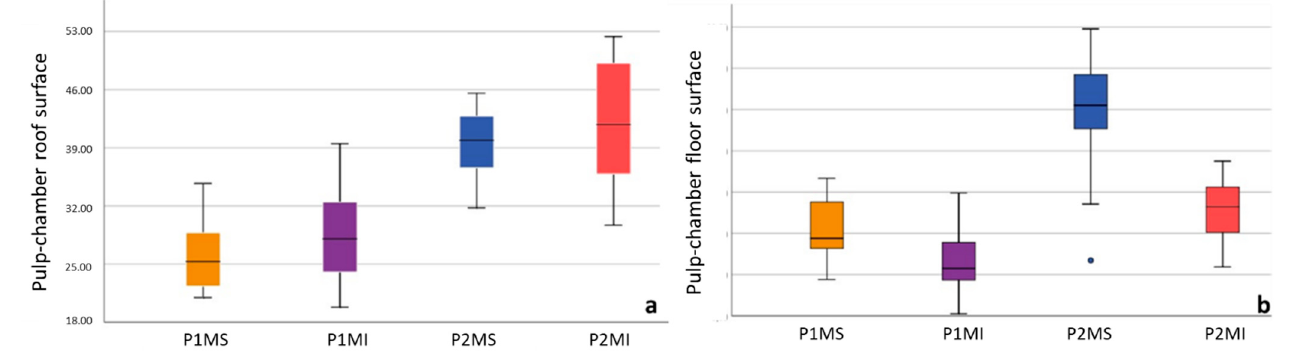
Figure 7. Box plot of pulp chamber surfaces (mm 2 ): pulp chamber roof surface ( a ); pulp chamber floor surface ( b ). Outlier data in P2MS box of pulp chamber floor surface ( • ). The limits obtained at the 95% confidence interval, regarding the length of the pulp chamber floor to the furcation, were 0.92 and 1.13, respectively, in the P1MS, 0.74 and 0.88 in the P1MI, 1.10 and 1.35 in the P2MS, 1.16 and 1.37 in the P2MI (Figure 8).